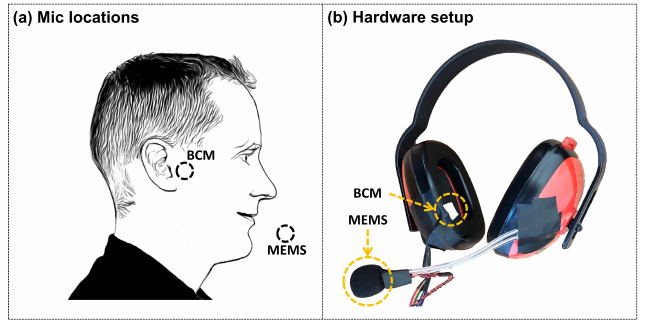
Figure 6. ( a ) The position of the air (MEMS) and the bone (BCM) conduction microphone. ( b ) The headphone prototype for data